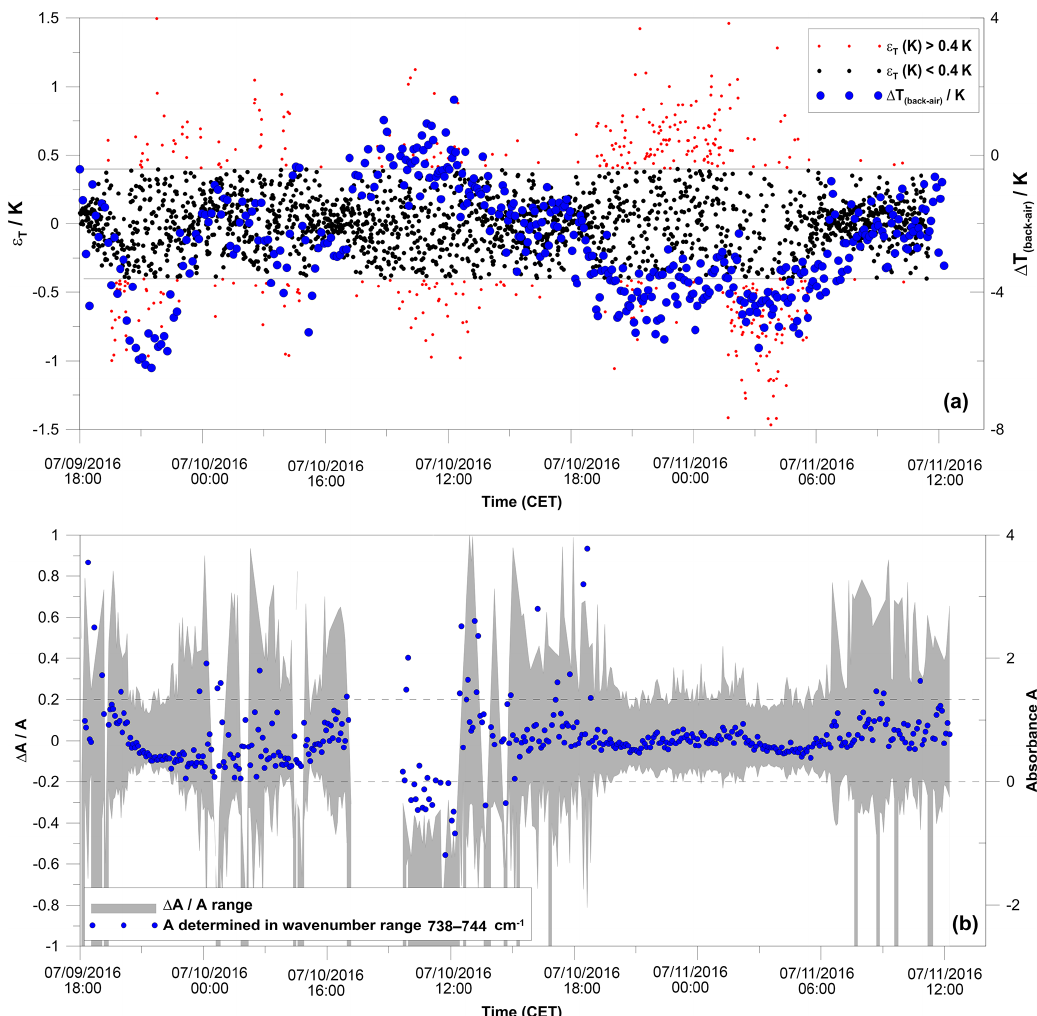
Figure 11. (a) Comparison of obtained temperature differences ( T B − T air ) derived from passive radiance spectra and measured horizontal sonic temperature differences derived from two measurement points. The latter is used as estimation for the air temperature error ε T . (b) The temperature data reveal measurements resulting in increased relative absorbance errors higher than 20% due to increased air temperature error ε T > 0 . 4K and decreased temperature differences | T B − T air | <